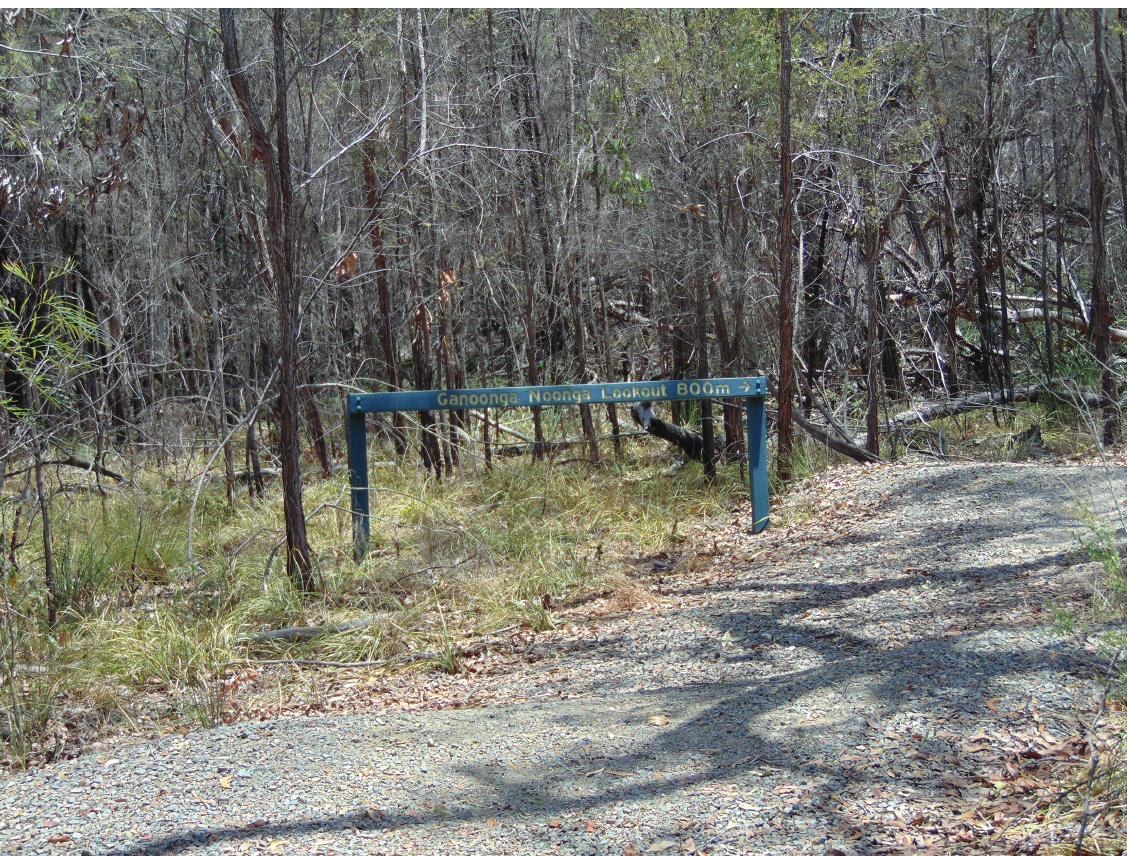
Fig. 10. Habitat of Cleotyche ( Cleotyche ) francescoi sp. nov. in Eurimbula National Park, 9 Dec.